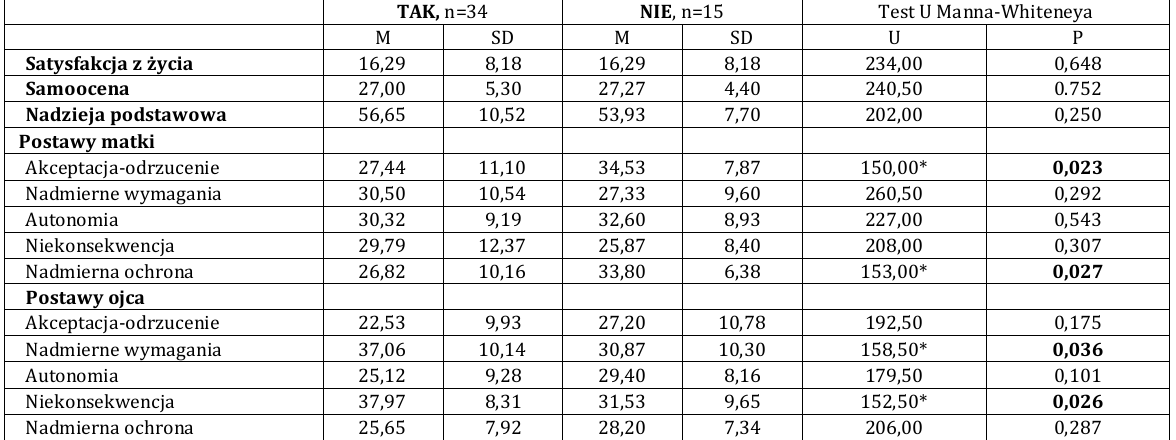
Tabela 2. Porównanie poziomu satysfakcji z życia, samooceny i nadziei podstawowej oraz retrospektywnej oceny postaw rodziców z uwzględnieniem występowania przemocy w